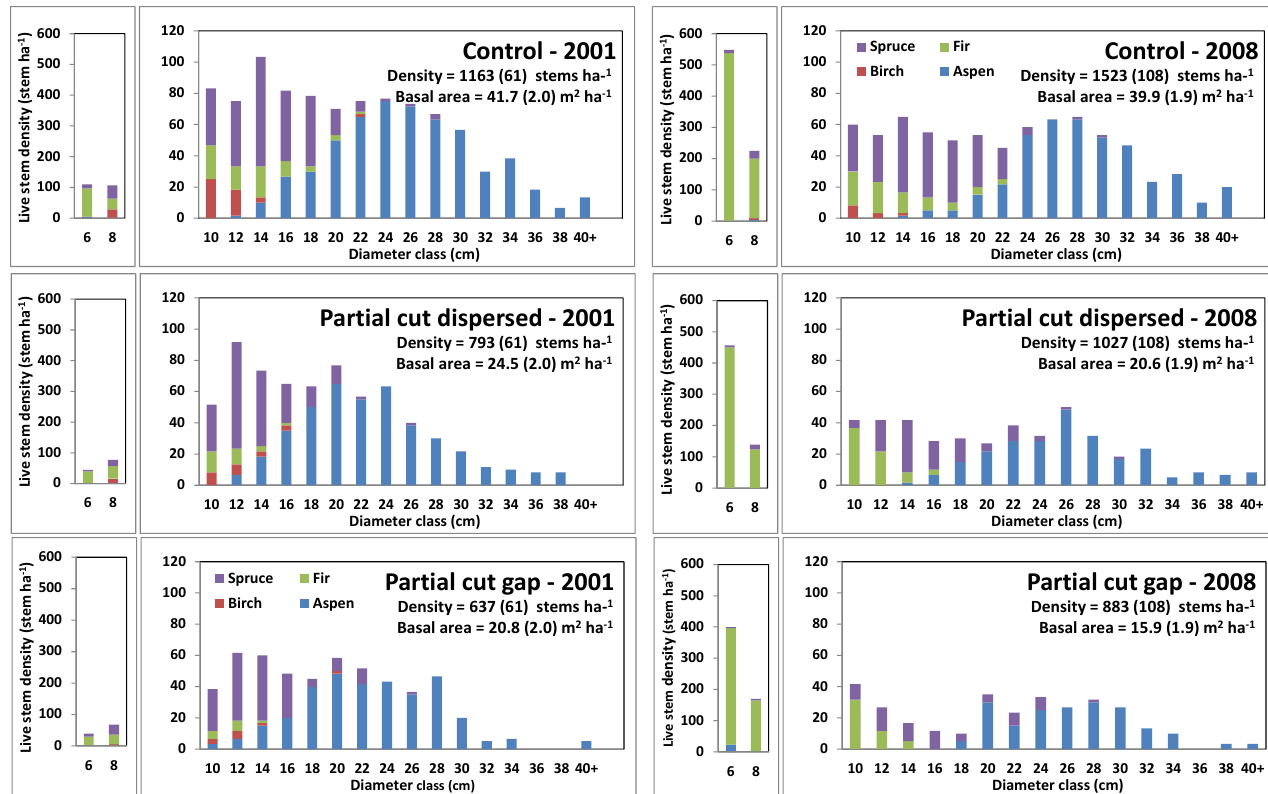
Figure 2. Diameter distribution of live stems immediately (spring of 2001) and eight years (2008), following the partial harvesting of mixed boreal stands. Values in brackets are standard deviations. Total density and basal area values include stems 5 cm diameter at breast height (dbh) and